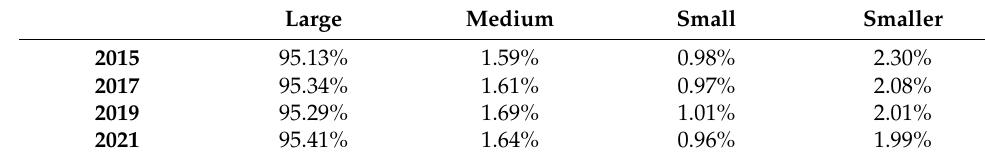
Table 7. The changes to bare land areas at different scales.